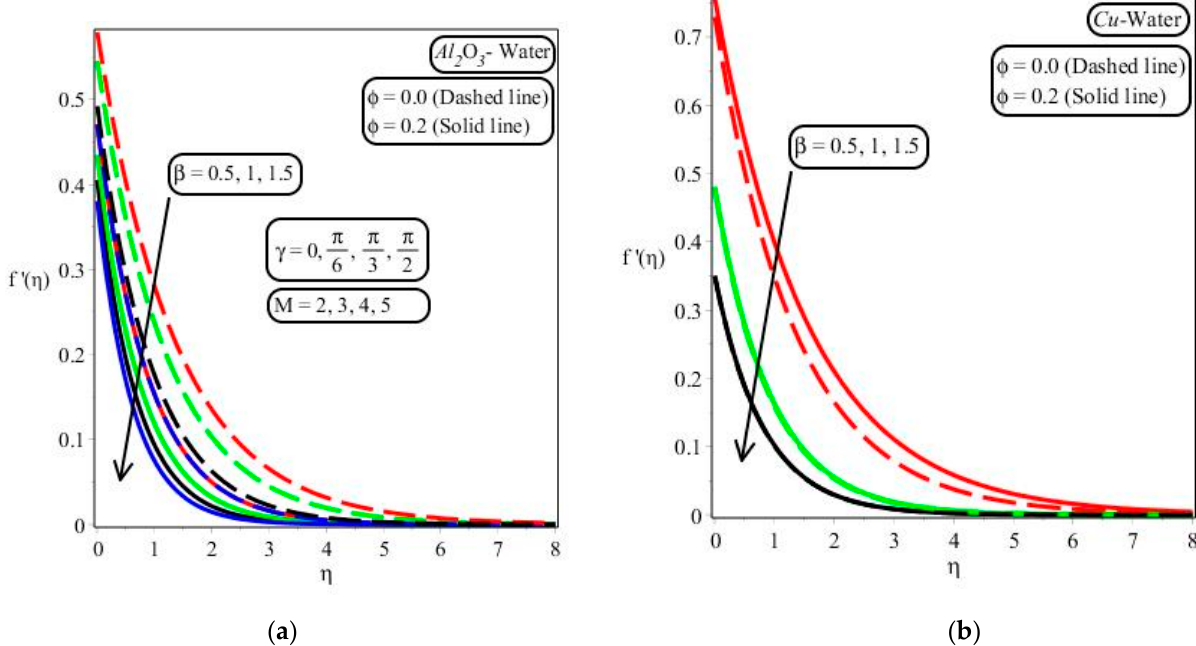
Figure 4. ( a , b ) Impact of β on velocity profile with γ = π /3, K 1 = 0.7, and M = 0.2.